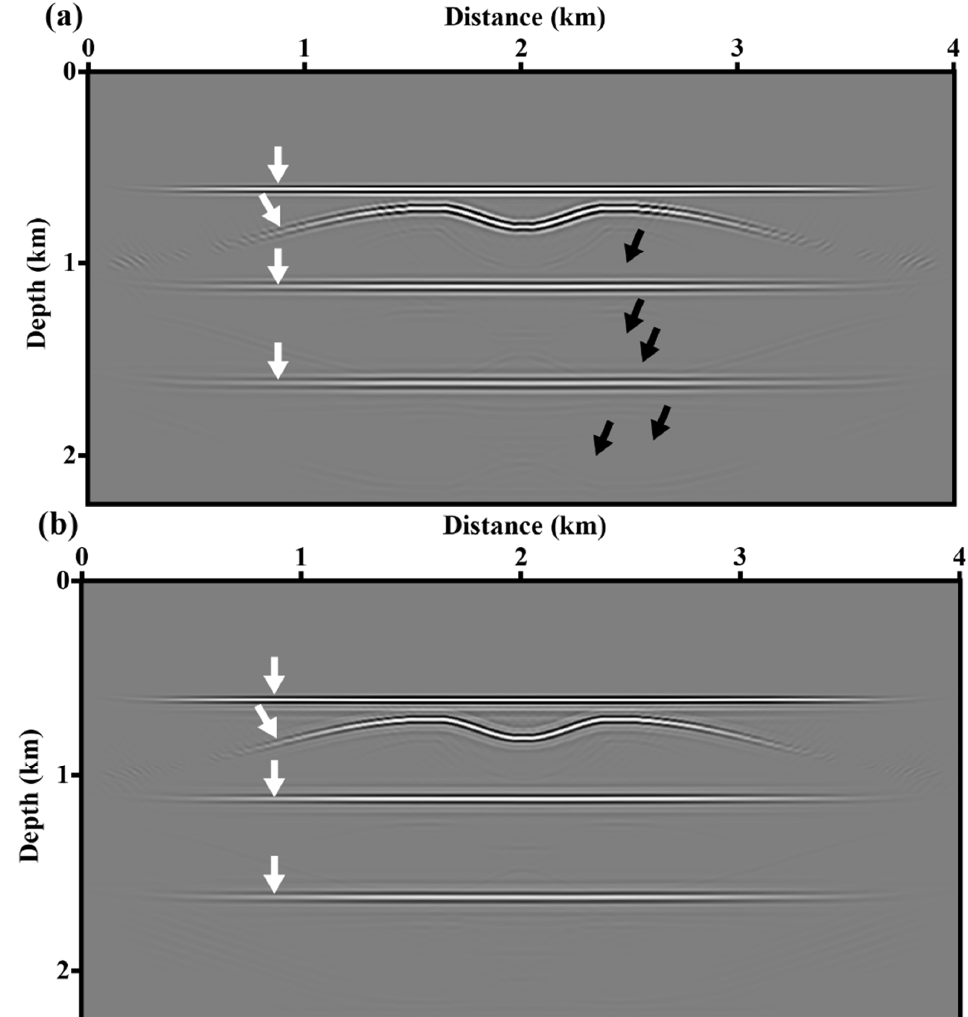
Figure 5. ( a ) The RTM-WM image and ( b ) the LSRTM-WM (six iterations) image.